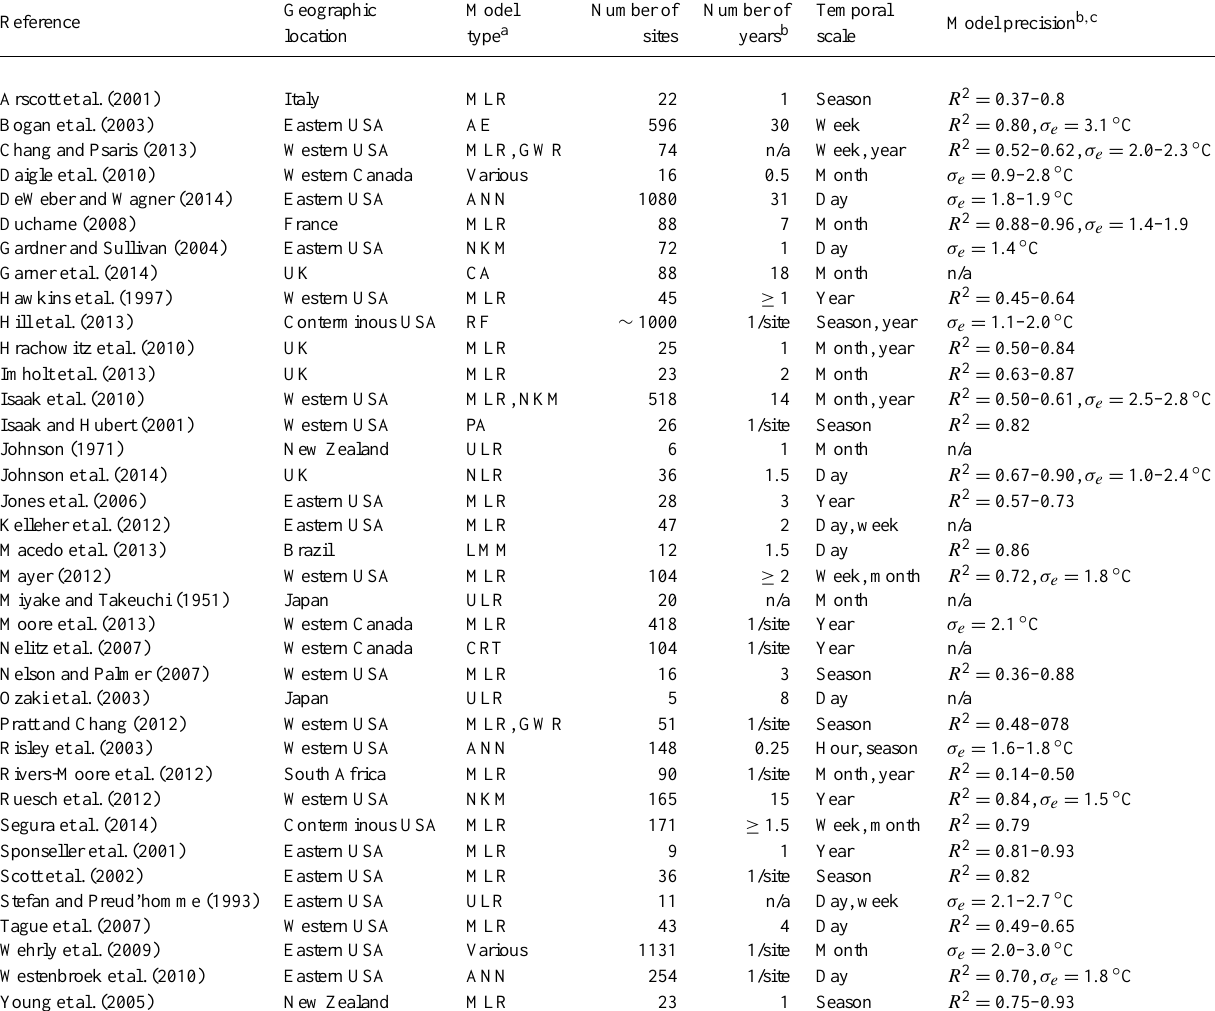
Table 1. List of reviewed publications about statistical stream temperature prediction in ungauged